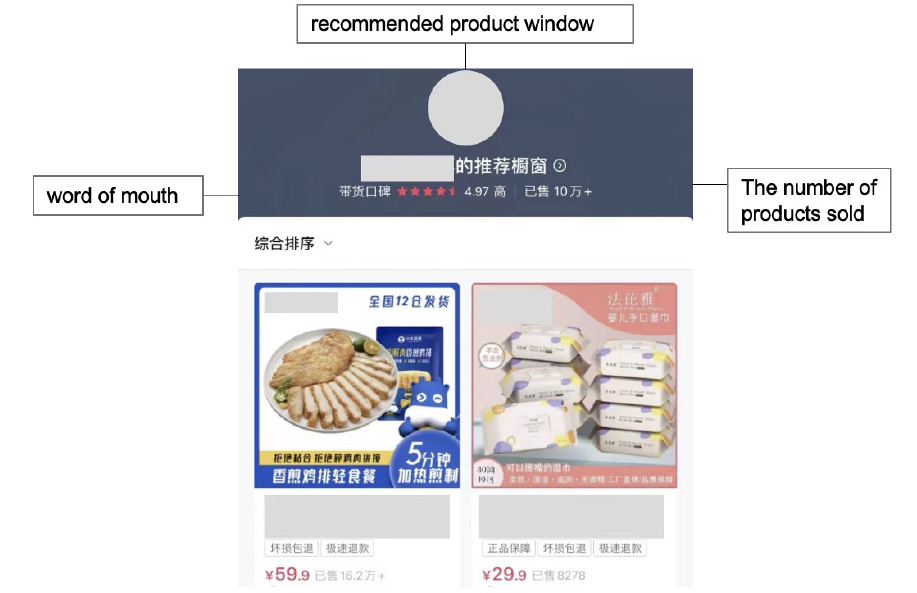
Figure 2. Di’s recommended product window.